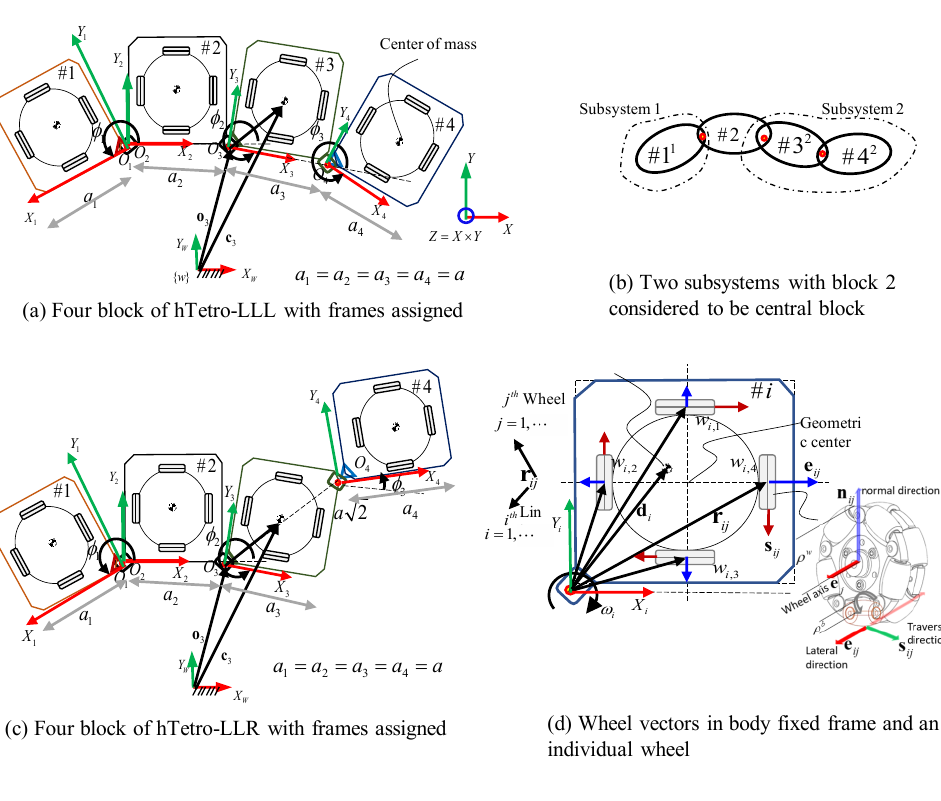
Figure 4. hTetro dissections in the form of -LLL and -LLR with the frames assigned along with the wheel arrangements. Table 1. DH parameters of hTetro-LLL and